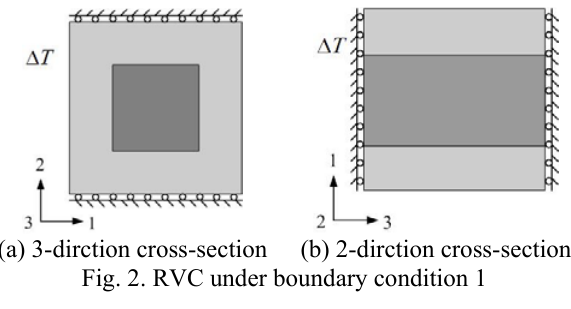
Fig. 2. RVC under boundary condition 1